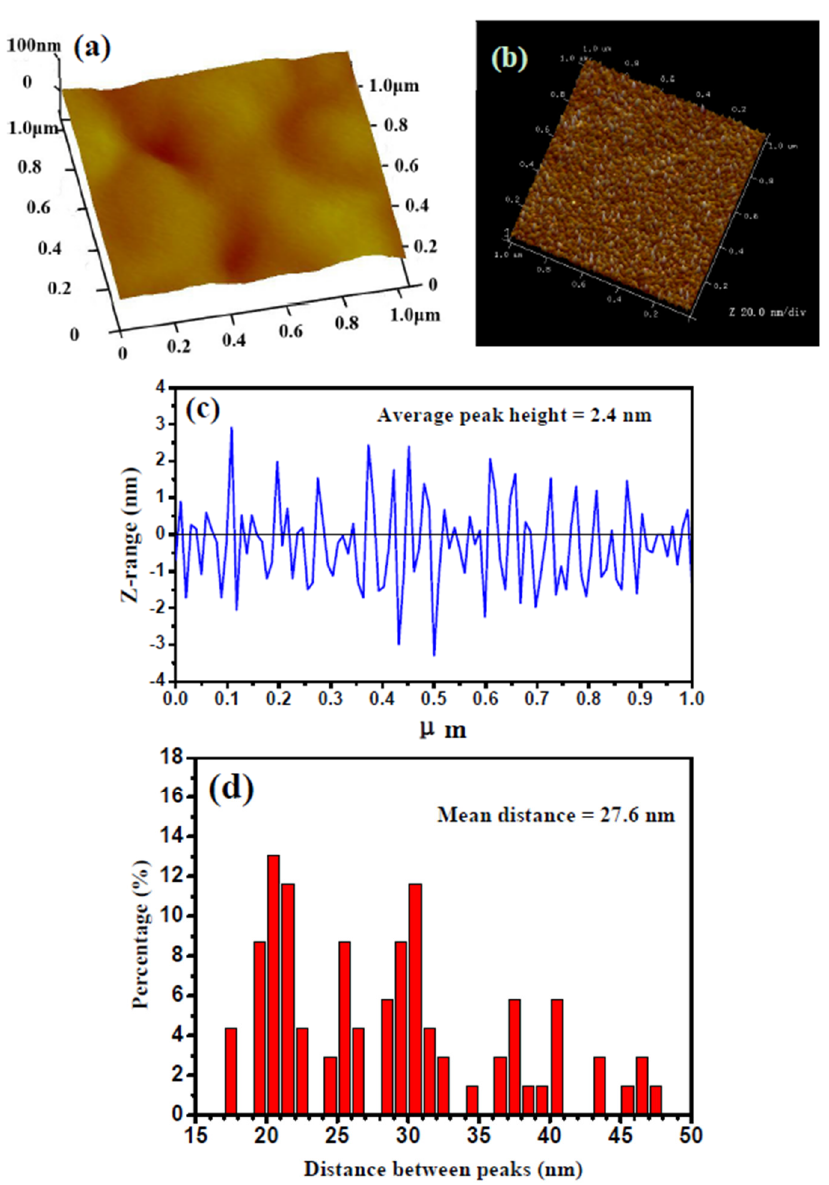
Figure 2. AFM surface topography of the polished Ti ‐ 6Al ‐ 4V alloy ( a ) before and ( b ) after sputter deposition of a Ta coating; ( c ) Line profile; and ( d ) corresponding histogram describing the distribution of peak distances for the as ‐ deposited β‐ Ta coating.